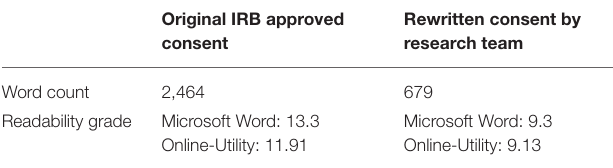
TABLE 2 | Readability